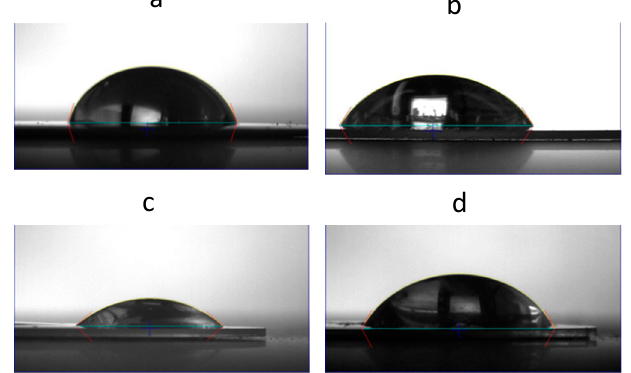
Figure 3. Water contact angles of: ( a ) Nafion, ( b ) (Naf/Lys) 6 , ( c ) (Naf/Chi) 6 , and ( d ) (Naf/Lys/Naf/Chi) 2 coatings deposited on QCM-D crystals.